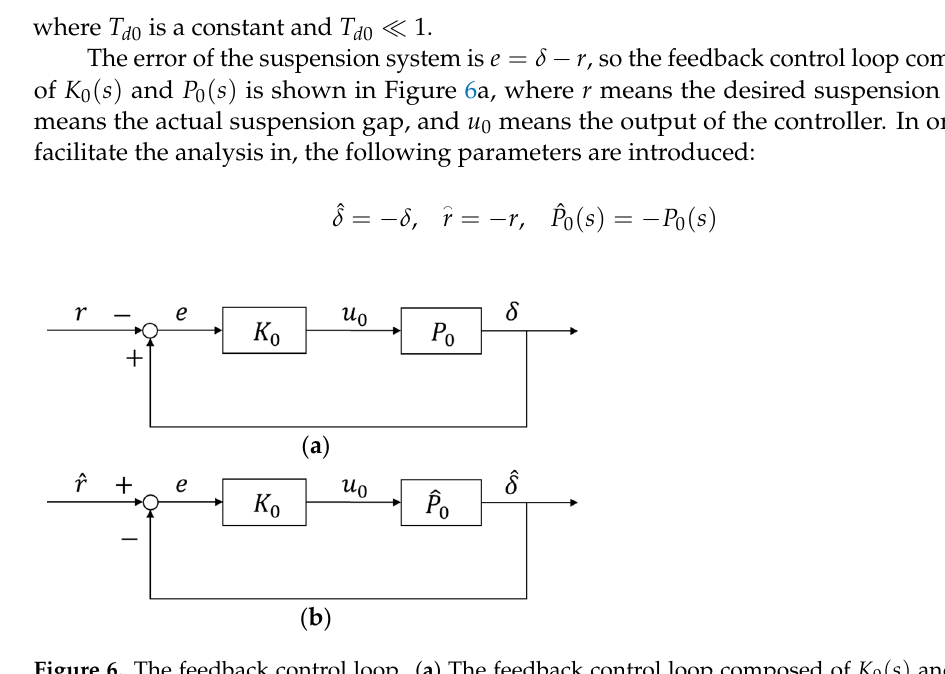
Figure 6. The feedback control loop. ( a ) The feedback control loop composed of K 0 ( s ) and P 0 ( s ) . ( b ) The feedback control loop is composed of K 0 ( s ) and ˆ P 0 ( s )